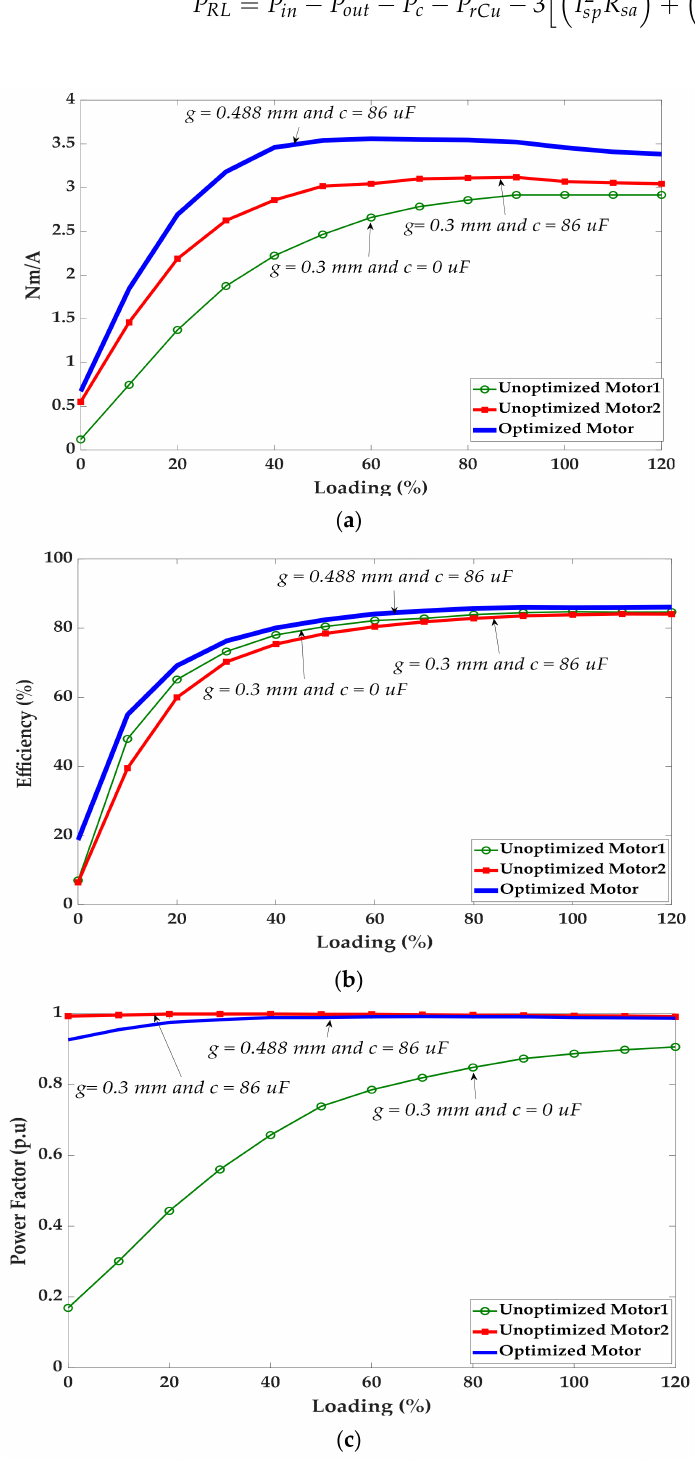
Figure 9. Comparison between unoptimized motors and a motor with an optimal air gap length and capacitor value: ( a ) torque per ampere vs. loading; ( b ) efficiency vs. loading; ( c ) power factor vs.